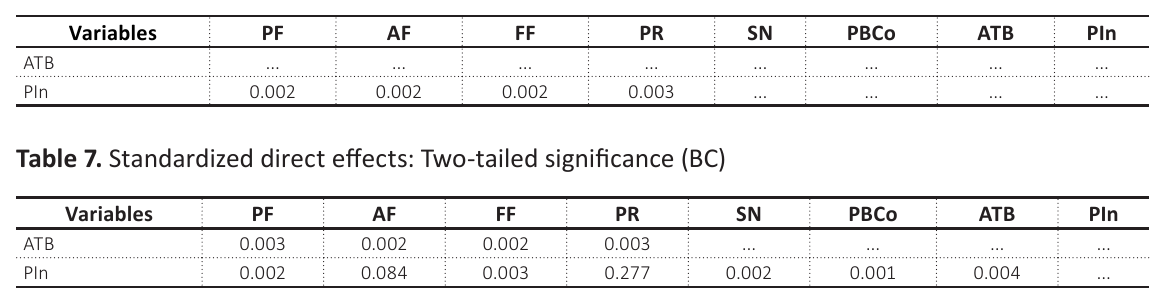
Table 6. Standardized indirect effects: Two-tailed significance (BC)